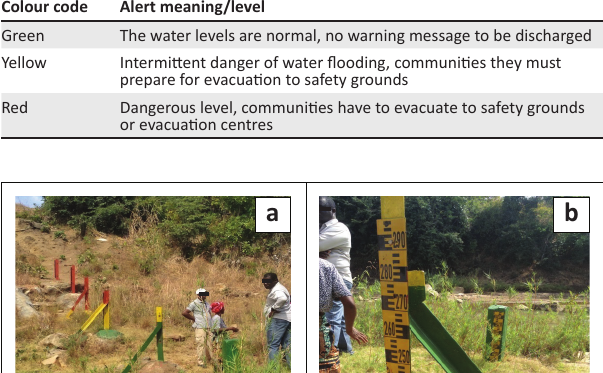
TABLE 1: River gauge colour sode meaning. Colour code